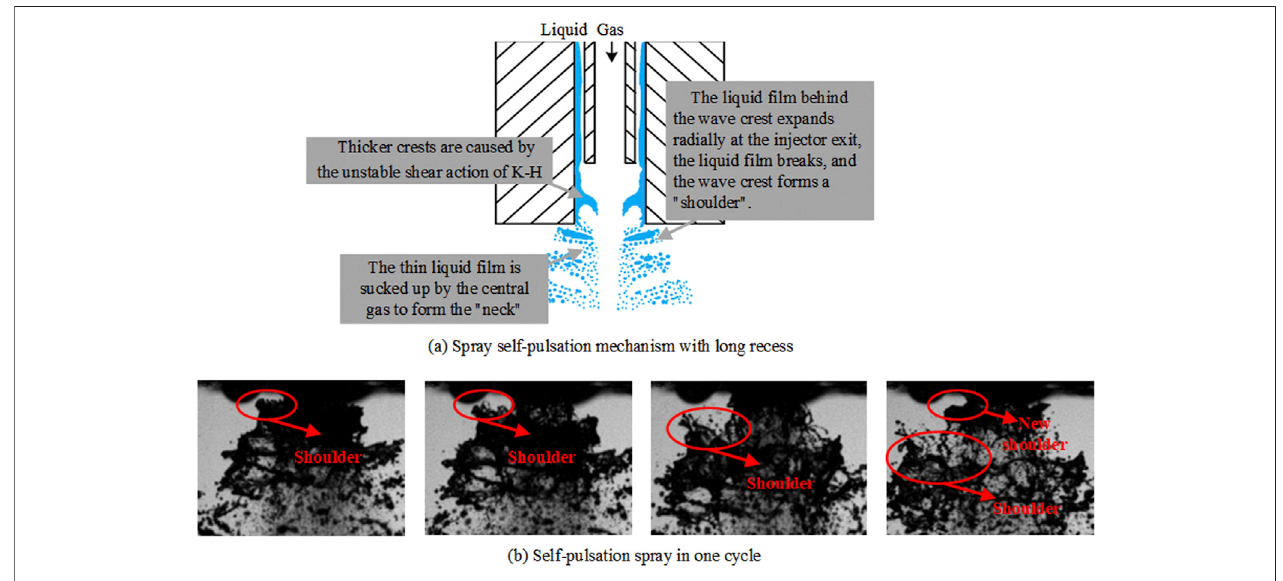
FIGURE 14 | Self-pulsation mechanism with long recess.